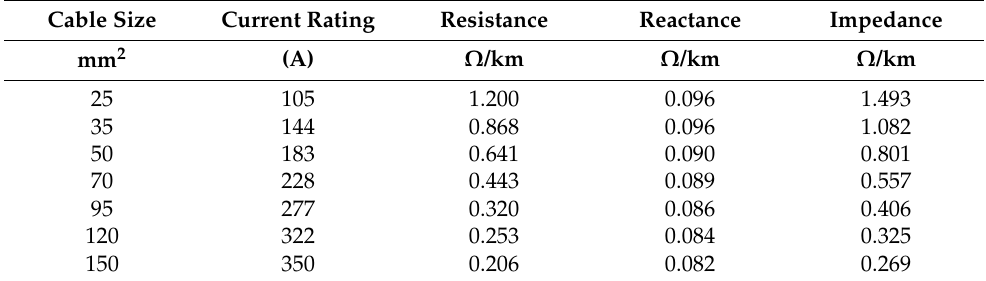
Table 2. A representative section of the conductor inventory based on aluminum conductor steel reinforced (ACSR) conductors.